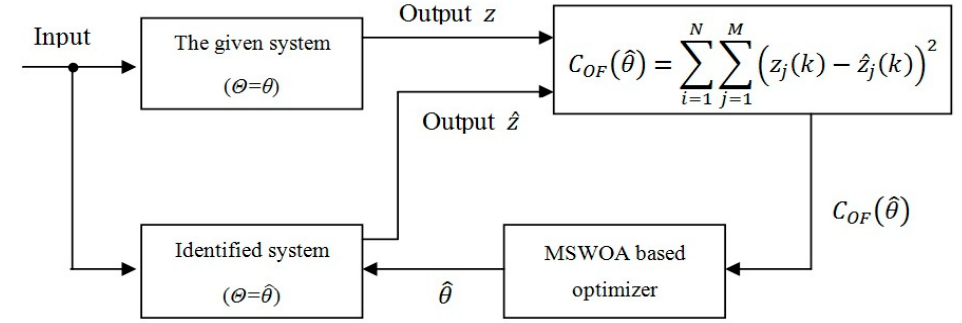
Figure 7. Diagram of parameter identification of HTGS based MSWOA.